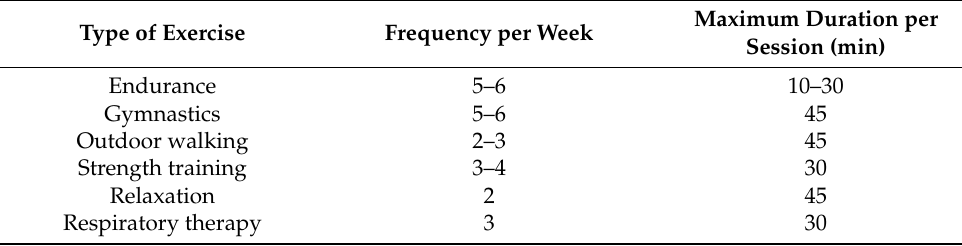
Table 1. Available exercise frequency and minutes of therapies. Type of